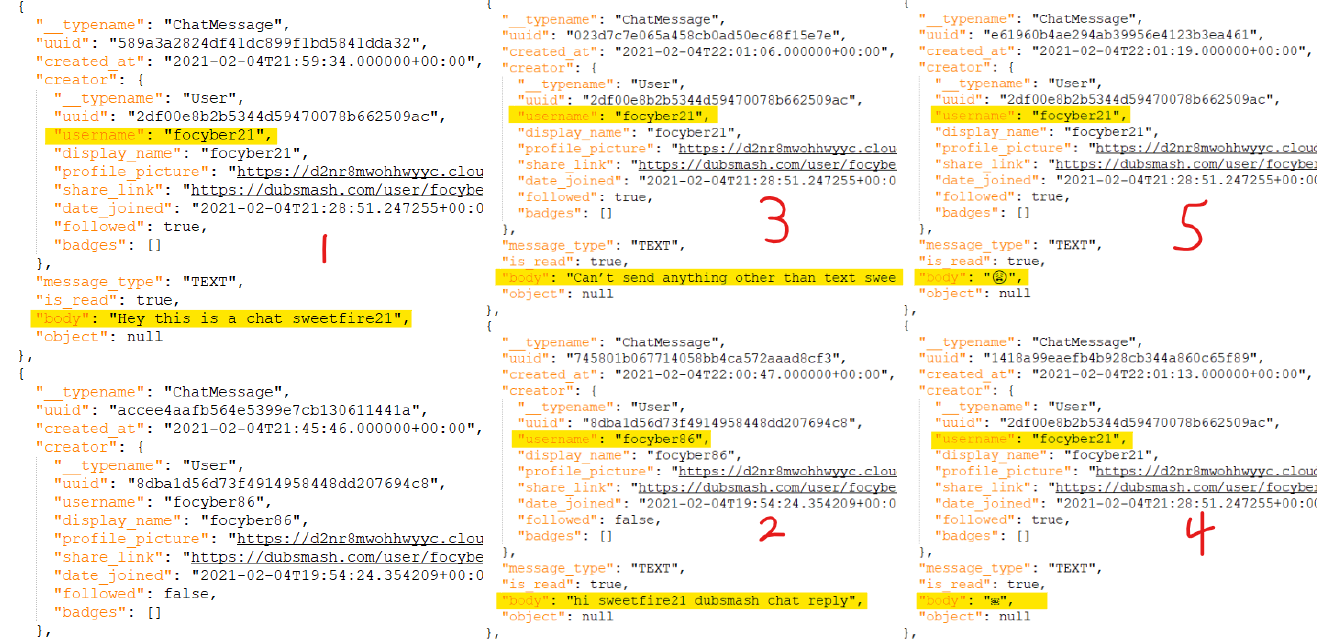
Figure 12. Full chat history between the Android and iOS accounts, as recovered from the Dubsmash app on